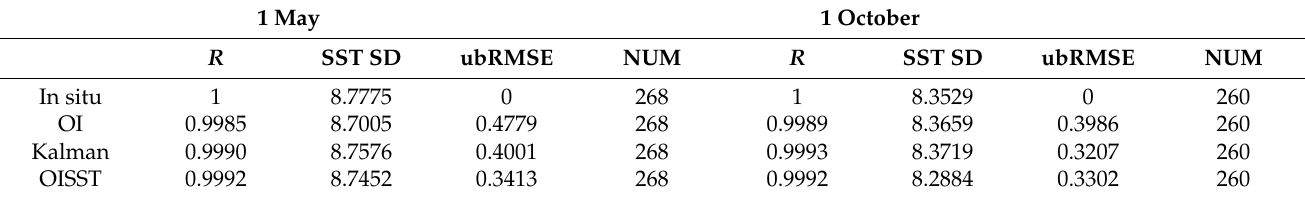
Figure 13. Comparison of the OI, Kalman, and OISST results with the in situ SSTs from ( a ) 1 May 2016 and ( b ) 1 October 2016 using Taylor diagrams. Table 2. Error Statistics of the in situ SST, OI, Kalman, and OISST results from 1 May and 1 October 2016.